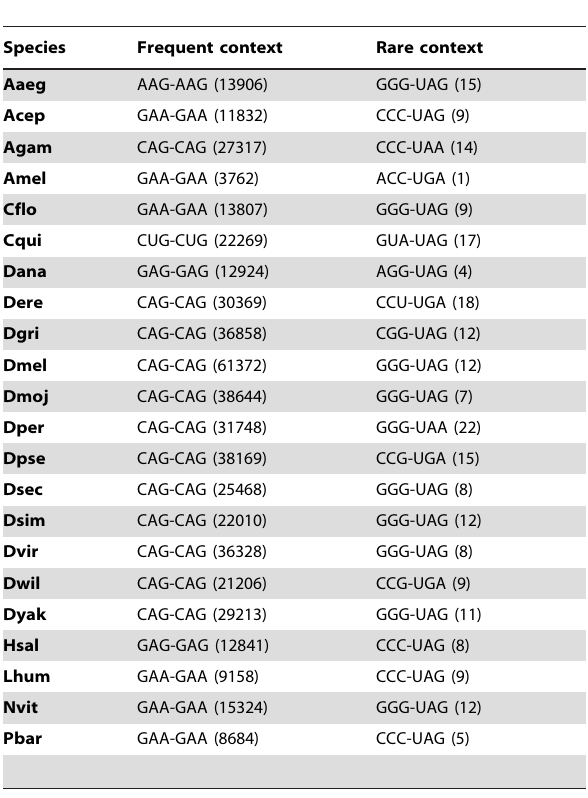
Table 5. The most frequent and the most rare context sequences of codons in different